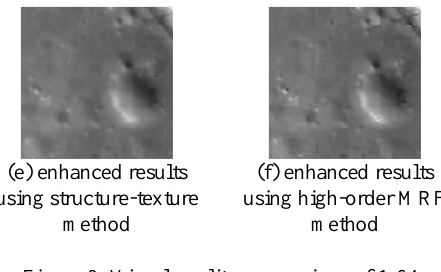
Figure 3. Visual quality comparison of 1:64